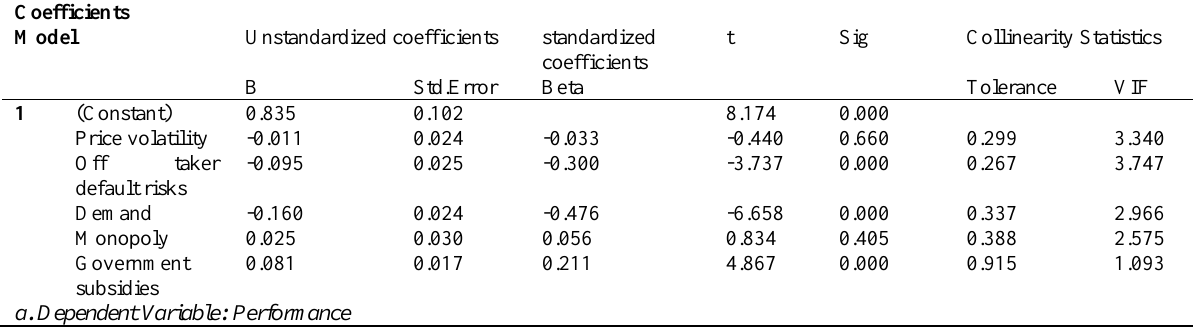
Table 6: Regression